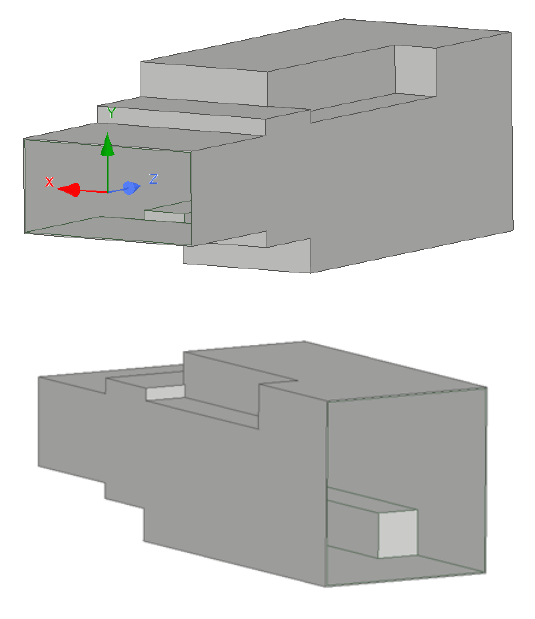
FIGURE 1. HFSS 3D Model of the Waveguide Polarizer.